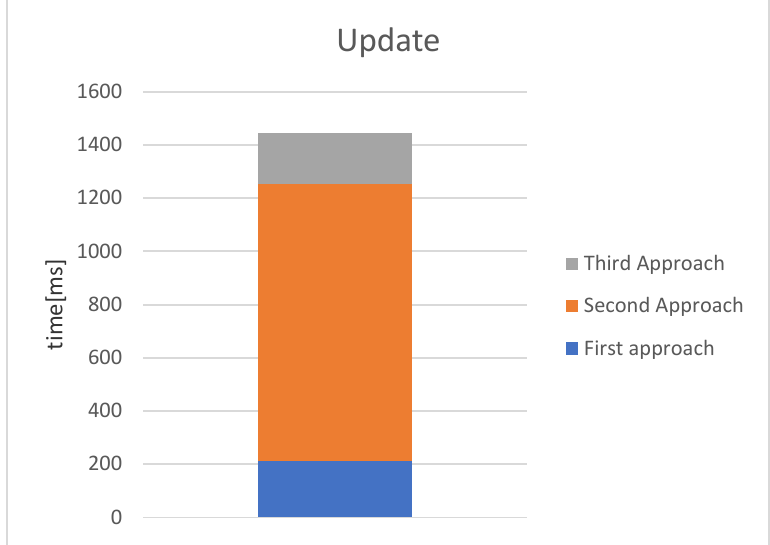
Figure 12. Results for update operation.